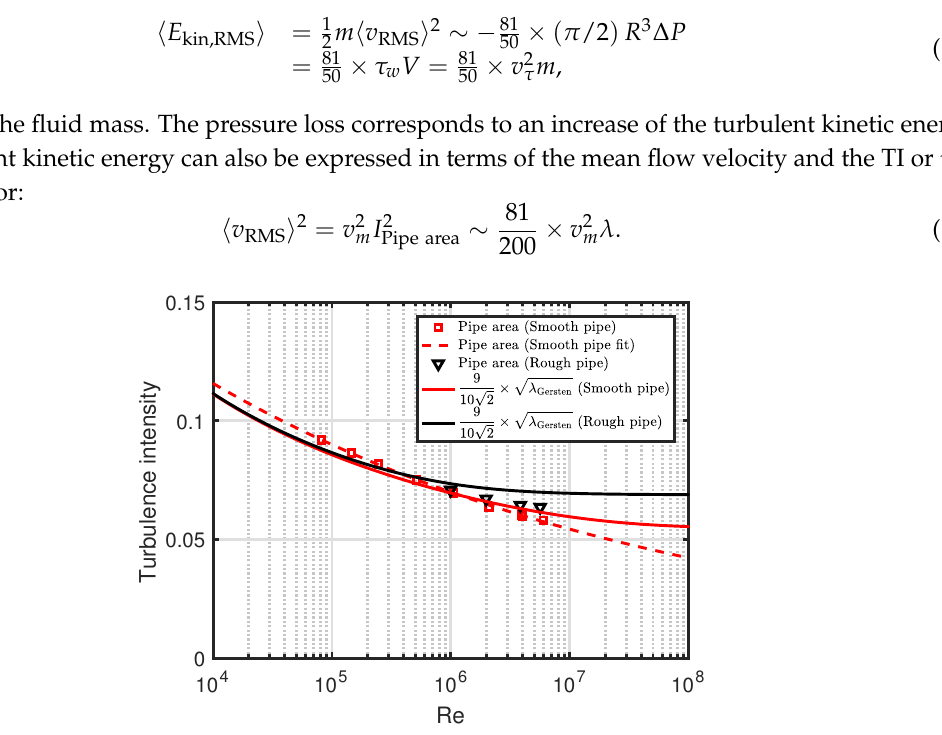
Figure 9. Turbulence intensity for smooth and rough pipe flow. The approximation in Equation (14) is included for